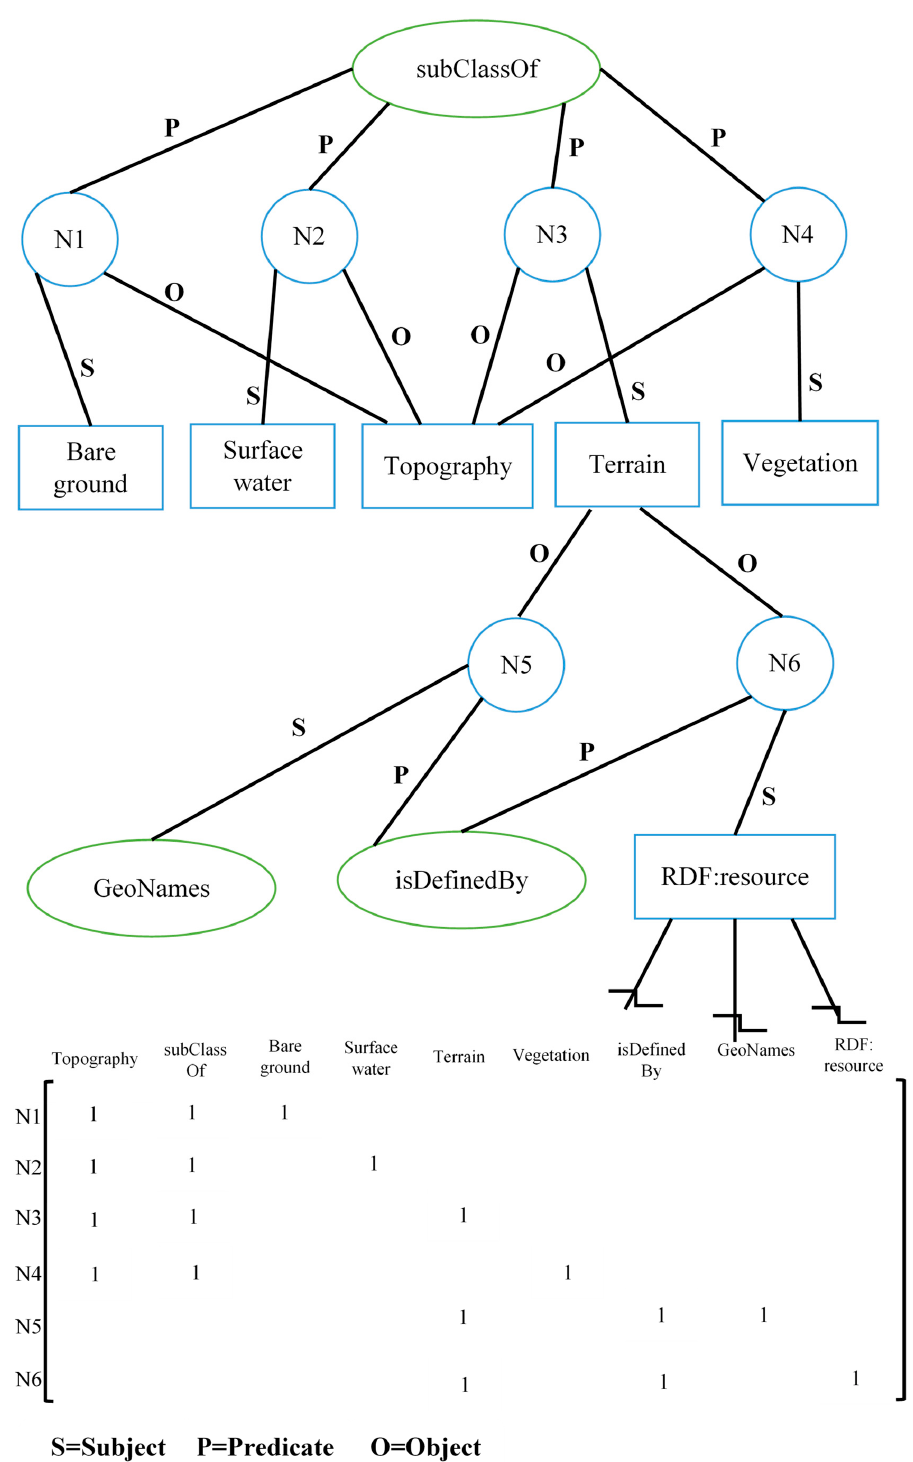
Figure 5. RDF bipartite graph and matrix representation of the GIS ontology example.